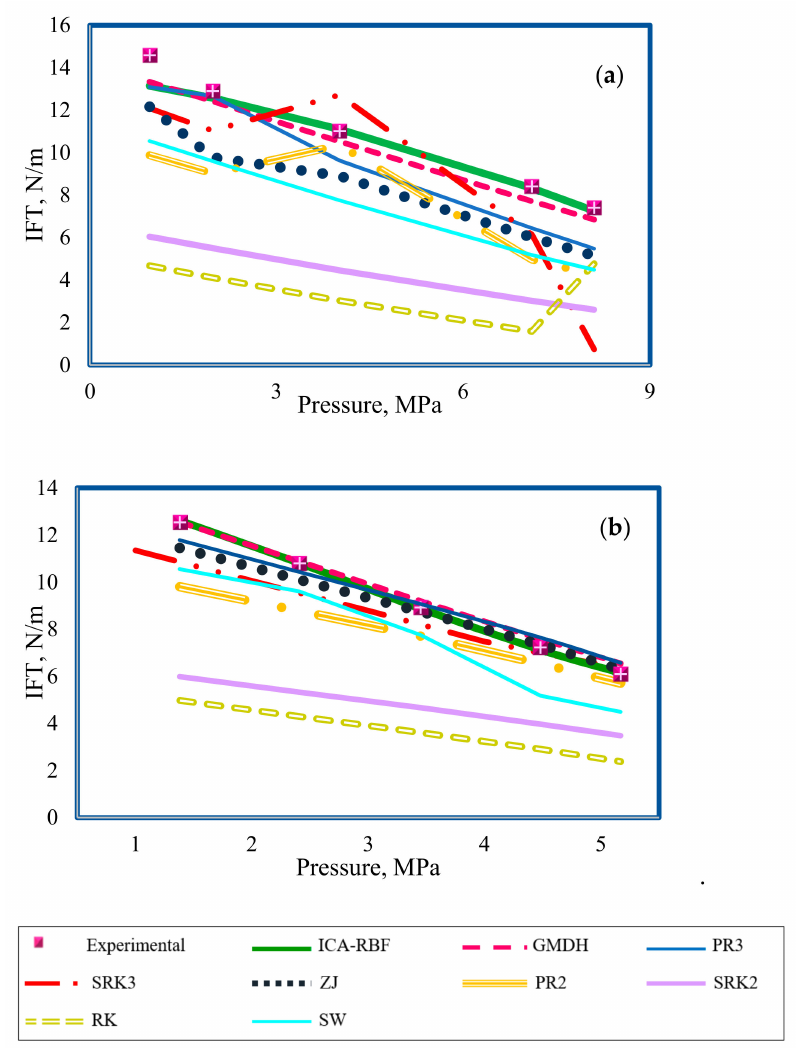
Figure 10. A comparison between the experimental ( a ) CO 2 –nC10 and ( b ) CO 2 –nC7 IFT values and the estimated IFTs using the Parachor equation ( n = 4) in combination with several EOSs, while investigating effect of